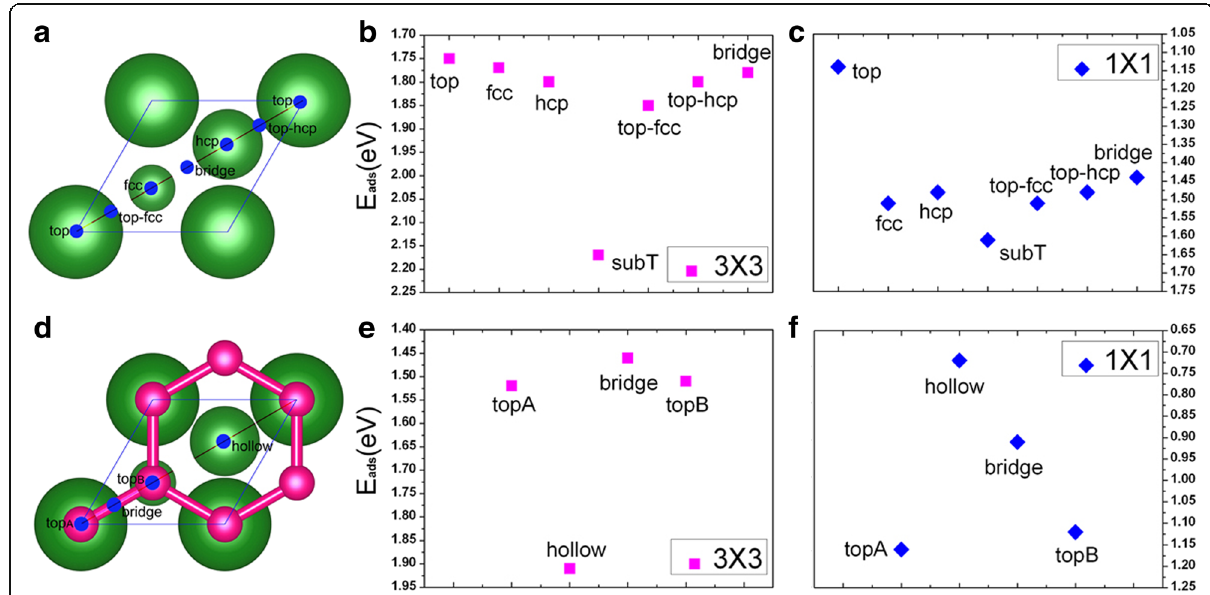
Fig. 1 a Adsorption sites on a clean Cu(111) (1 × 1) surface: largest balls indicate surface Cu atoms, and smaller balls indicate sub-layer Cu atoms; b , c adsorption energies of different adsorption sites of V atoms on Cu(111) at 1/9 ML and 1 ML coverages, respectively; d a graphene-covered Cu(111) (1 × 1) surface, red balls indicate C atoms of graphene; e, f adsorption energies of V atoms on graphene-covered Cu(111) at 1/9 ML and 1 ML coverages, respectively